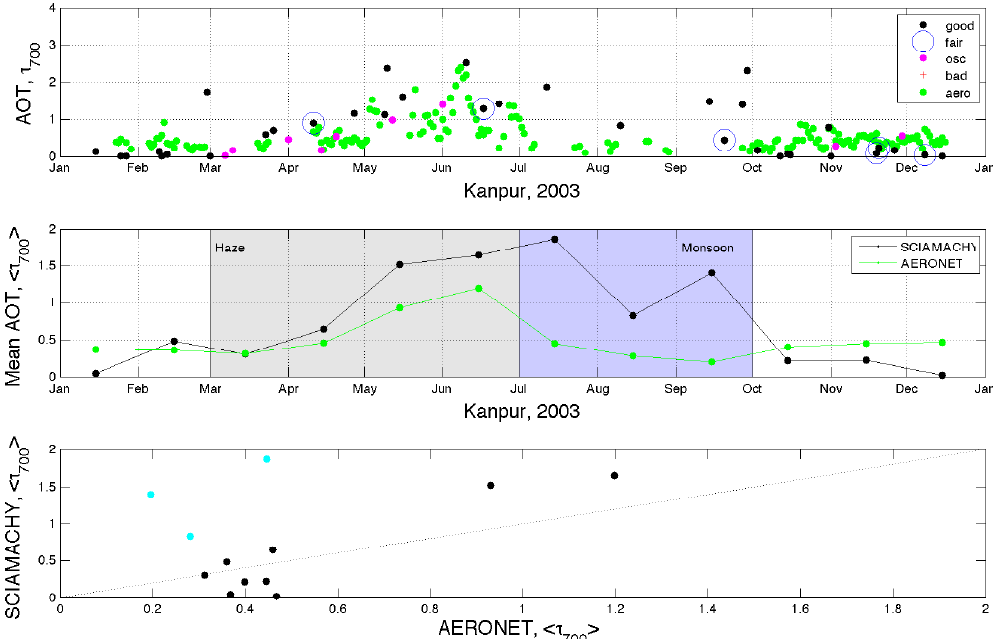
Fig. 11. Top panel: a time series of all AERONET measurements of AOT (675nm) at Kanpur over the year 2003 (green dots), all SCIA- MACHY retrievals of τ 700 < =4, color coded according to the goodness of the retrieval. Middle panel: A time progression of the monthly means of both sets of data, AOT measured by AERONET (green) and those retrieved from SCIAMACHY (black dots). Lower panel: a scatter plot of SCIAMACHY monthly means of AOT against AERONET values. Strongly cloud contaminated (SCIAMACHY) data are color-coded cyan. The black line is the 1:1 line. The non-monsoon monthly means show a high correlation coefficient of r